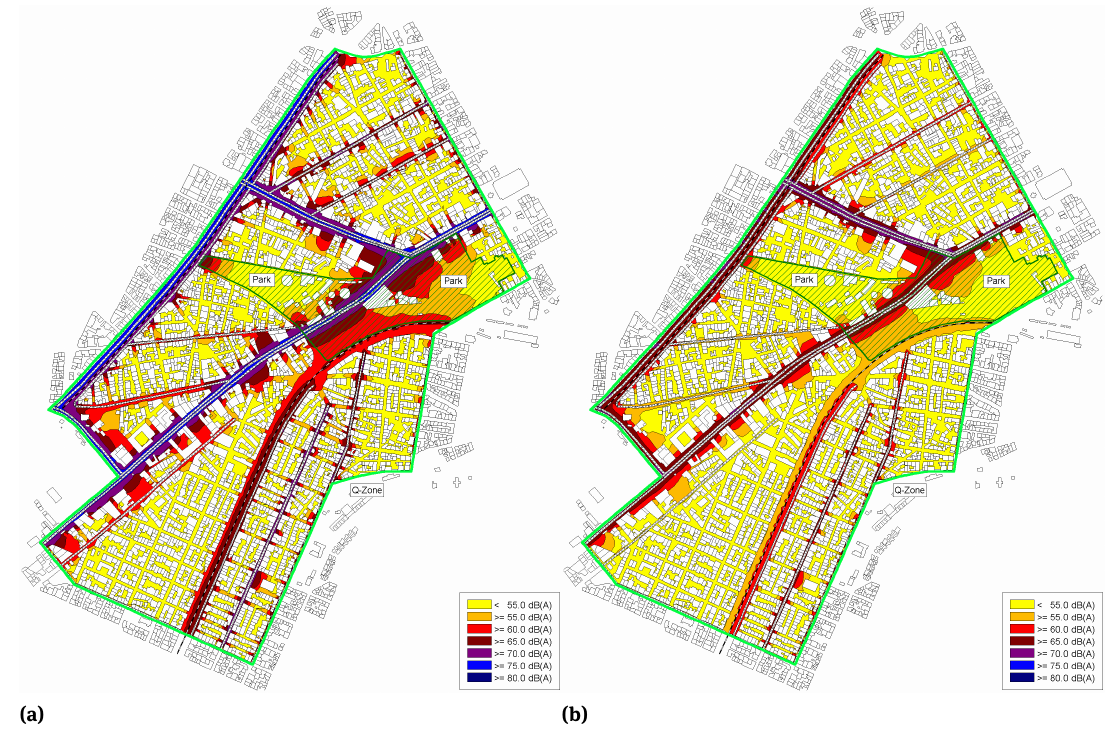
Figure 10: Scenario S05 - L